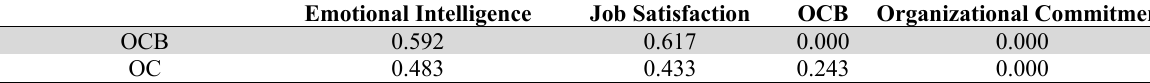
Standardized Direct Effects (Group number 1 - Default model)